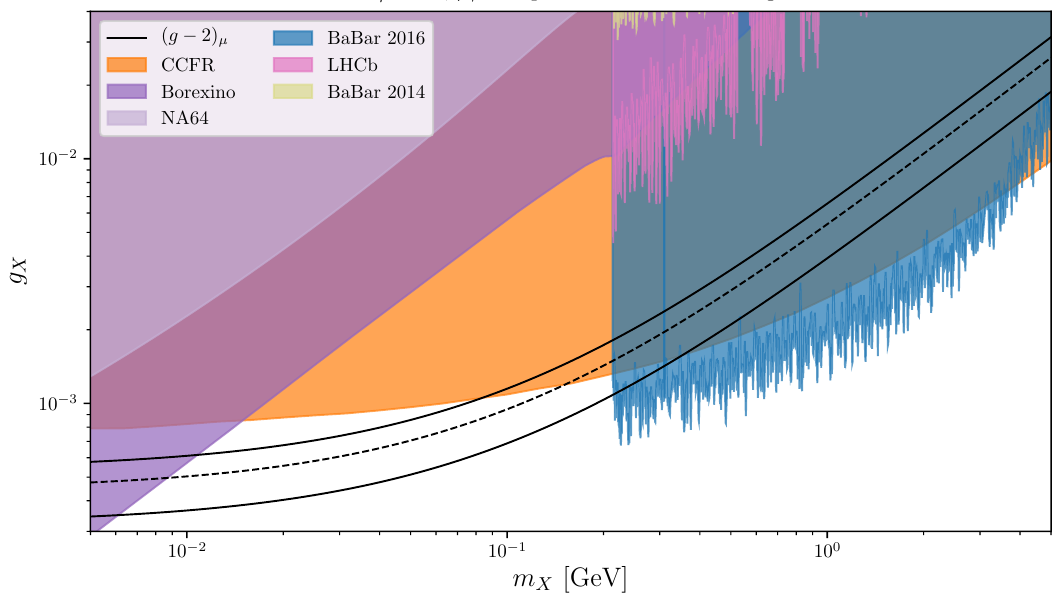
Figure 3 . Parameter space of the L µ − L τ model with the parameter space that explains the central value of ∆ a denoted with dashed black line (the 2 σ band by solid black lines). The exclusions by µ different measurements are color coded as given in the